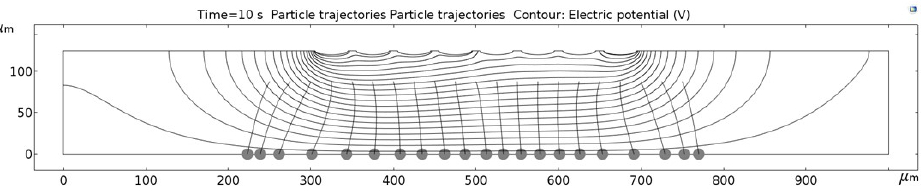
Figure 16. Computed particle trajectories and electric potential for the Parabolic pin electrode geometry.